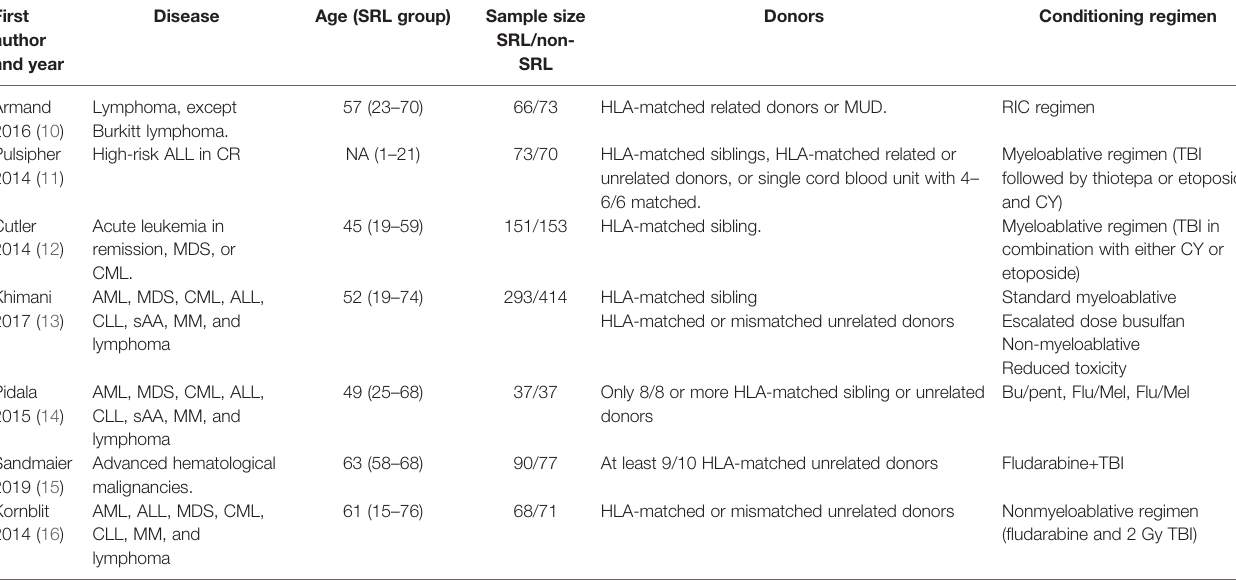
TABLE 1 | Characteristics of the included RCTs, comparing the SRL-based and non – SRL-based